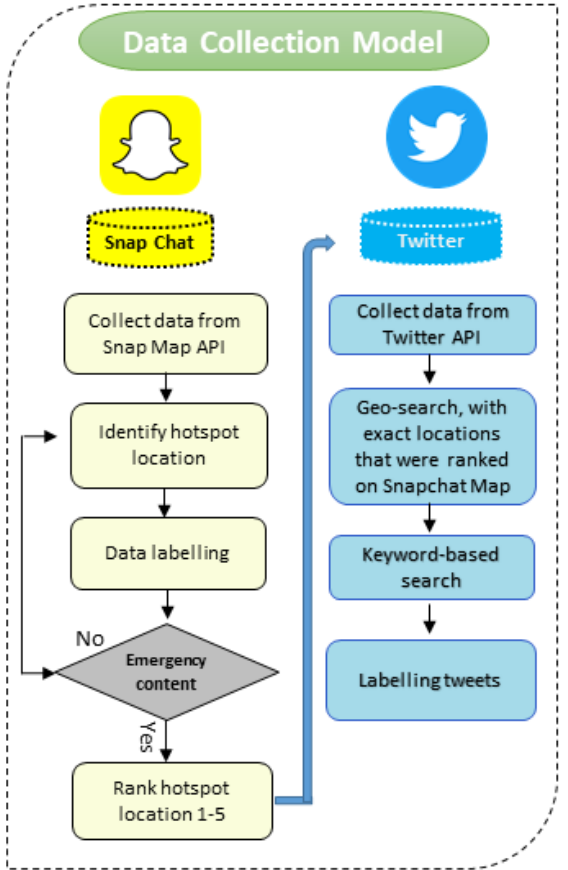
Figure 2. Data collection